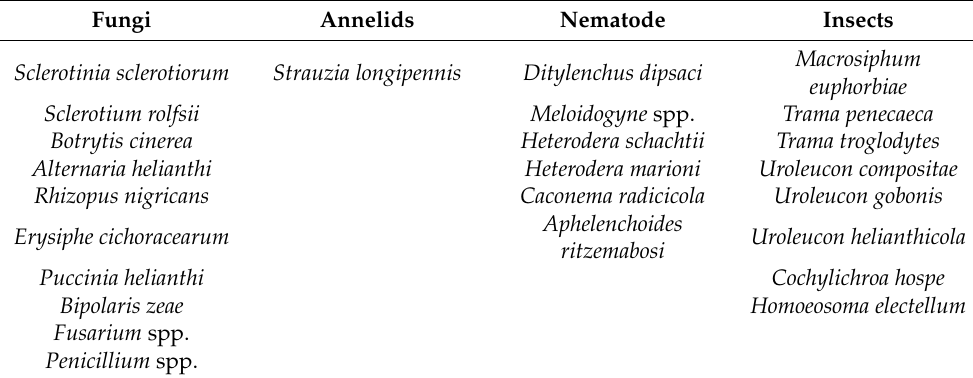
Table 1. Different species that produce biotic stress in H. tuberosus . Summarizes information adapted from